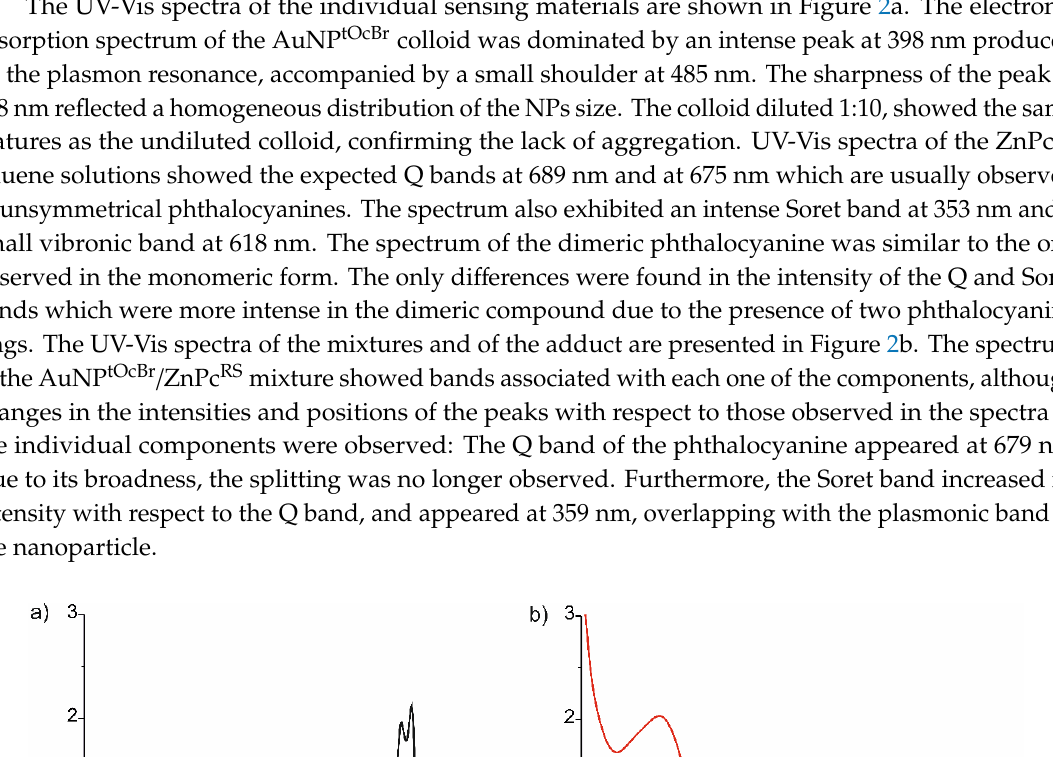
Figure 3. TEM images of ( a ) AuNP tOcBr , ( b ) mixture AuNP tOcBr /ZnPc RS , and ( c ) adduct AuNP tOcBr -S- ZnPc R . ITO glasses were modified with spin-coated films of the AuNP tOcBr /ZnPc RS , AuNP tOcBr /ZnPc R -S- ZnPc R mixtures and of the AuNP tOcBr -S-ZnPc R adduct. Their sensing properties towards catechol were analyzed using cyclic voltammetry. The electrochemical responses of a bare ITO and films prepared from individual components AuNP tOcBr , ZnPc RS , and ZnPc R -S-ZnPc R were also analyzed for comparison purposes. Voltammetric responses towards a 10 − 3 mol∙L − 1 catechol solution (in 0.01 M phosphate buffer as electrolyte pH = 7) are shown in Figure 4. As a general rule, responses were characterized by an anodic peak at positive potentials (produced by the oxidation of catechol to 1, 2 benzoquinone) and a cathodic peak at ca. − 0.25 V produced by the corresponding reduction of the benzoquinone. However, important differences were caused by the modification of the electrode. When a bare ITO electrode was immersed in catechol, peaks were quite weak. A small increase in the intensity of the peaks was observed when the ITO glass was coated with AuNP tOcBr . In contrast, ZnPc RS coated ITO glass produced an increase in the intensity of the anodic wave (from 3 µA in ITO